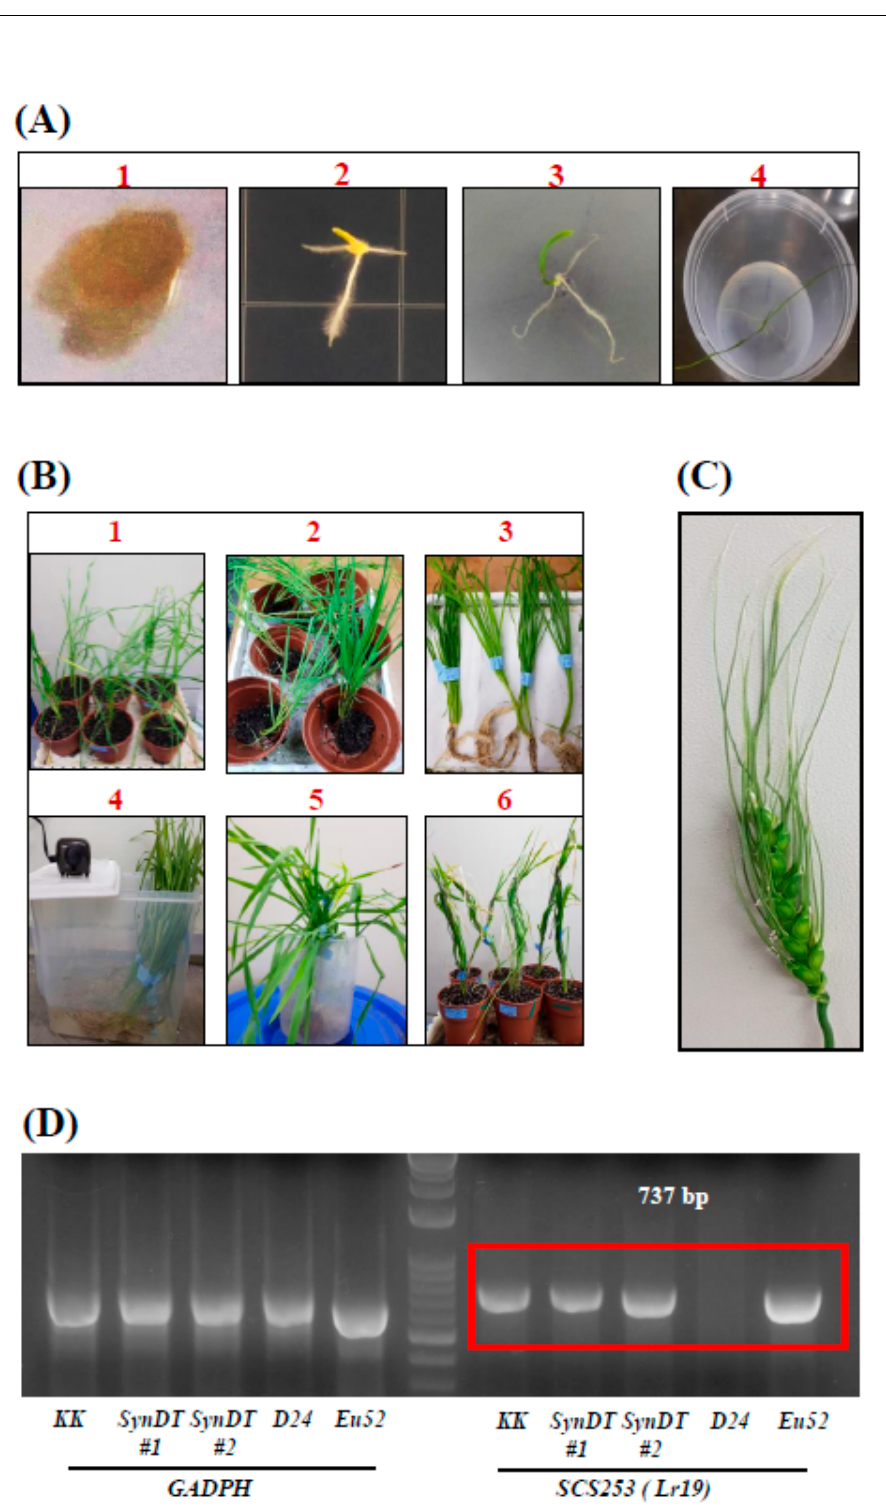
Figure 1. Procedure for generation and confirmation of synthetic wheat lines. ( A ) Rescue and growth of embryo of synthetic grains. (1) The embryo of synthetic grains. (2) One-week-old synthetic plants. (3) Two-week-old synthetic plants. (4) One-month old synthetic plants. ( B ) Procedure of colchicine treatment. (1) The ready and mature plants for colchicine treatment. (2) The soil from the root sites was removed, along with small, weak leaves. (3) The roots were washed with water and allowed to dry for 30 min. (4) The plants were immersed in colchicine solution and aerated for 6 h. (5) The plants were rinsed for 30 min with water. (6) The treated plants were re-planted inside the pots. ( C ) Spike of SynDT. ( D ) Confirmation of D genome in SynDT using a SCS253 marker.